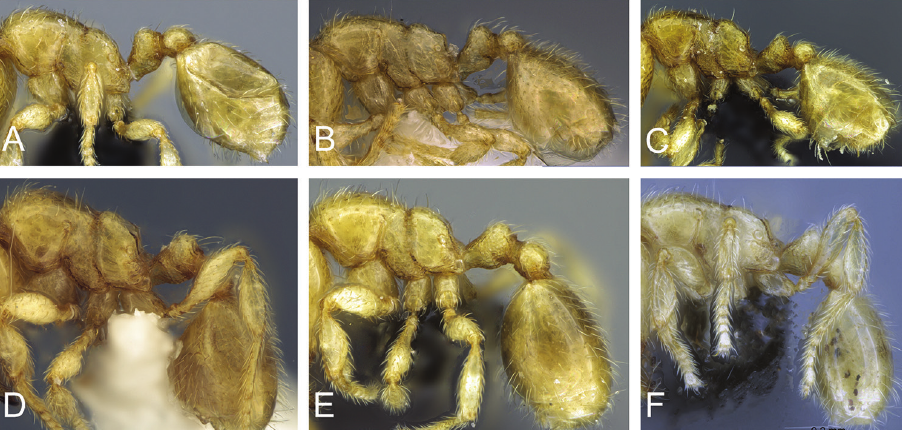
Figure 24. Mesosoma, petiole, postpetiole and gaster in profile view of A Carebara malagasy (CASENT0044172) B Carebara demeter (CASENT0127688) C Carebara betsi (CASENT0479432) D Carebara dota (CASENT0192570) E Carebara bara (CASENT0016716) F Carebara tanana (CASENT0211714). 11 In profile, dorsum of propodeum and declivity convex or weakly convex (Fig. 25A, B, C, D) ........................................................................................... 12 G, H) ........................................................................................................